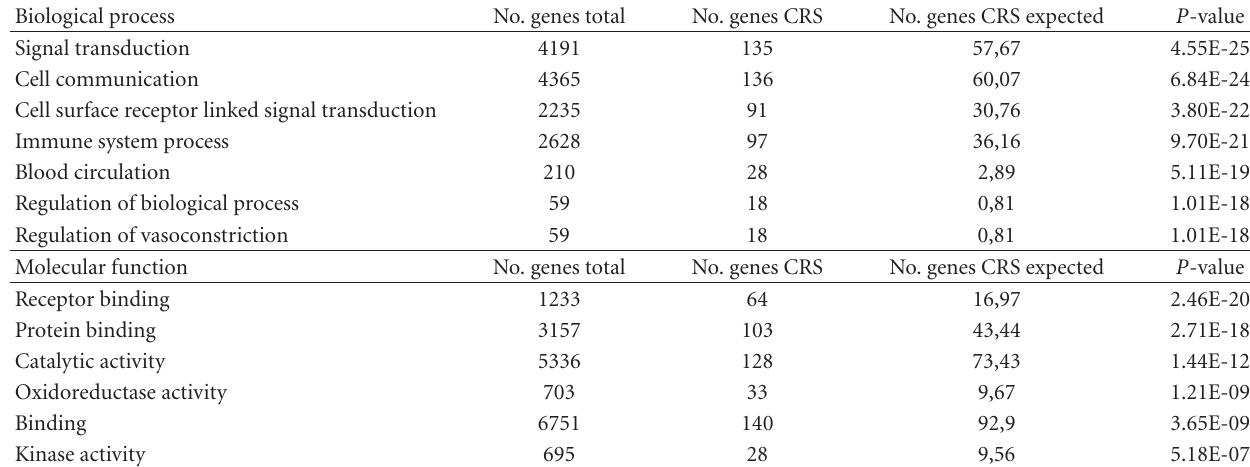
Table 2: List of enriched biological processes and molecular functions. Given are the total number of genes assigned to a process/function, the number of genes assigned as derived from literature mining, the number of genes expected from a statistical perspective, and the significance level of